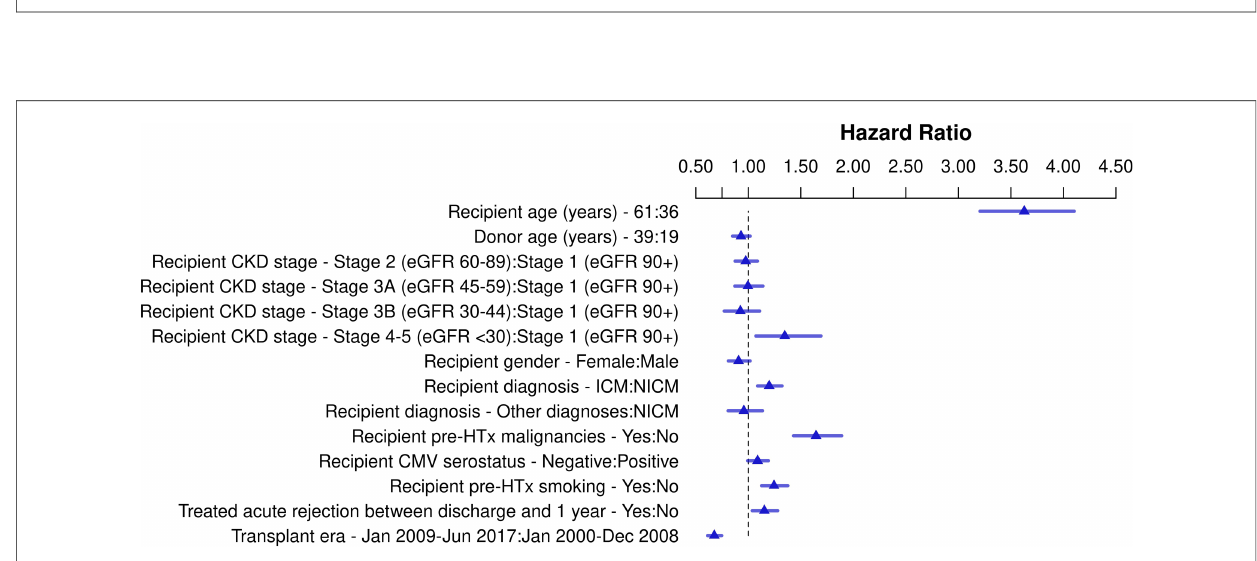
FIGURE 2 Schematic overview for risk factors for all malignancy post-heart transplant. Hazard ratios for continuous variables are shown for the third quartile vs. the fi rst quartile. CKD, chronic kidney disease; CNI, calcineurin inhibitor; CMV, cytomegalovirus; CYA, cyclosporine; eGFR, estimate glomerular fi ltration rate; HTx, heart transplantation; ICM, ischemic cardiomyopathy; IL-2RA, interleukin-2 receptor antagonist; NICM, non-ischemic cardiomyopathy; TAC, tacrolimus; VAD, ventricular assist device.